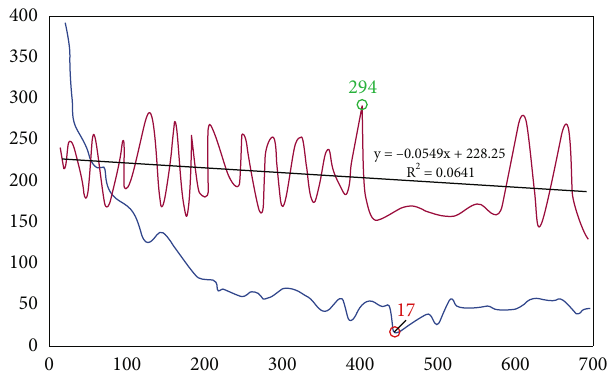
Figure 3: Maximum matching analysis of fi tting e ff ect of traditional vector space